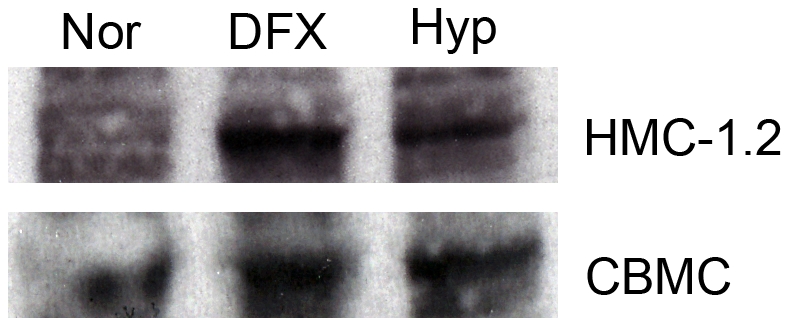
HIF-1α accumulation under hypoxia.HMC-1.2 and CBMC were cultured for 24 h under hypoxia or normoxia. HIF-1α accumulation was determined by western blot. DFX was used as a positive control. The figure is representative of three independent experiments.